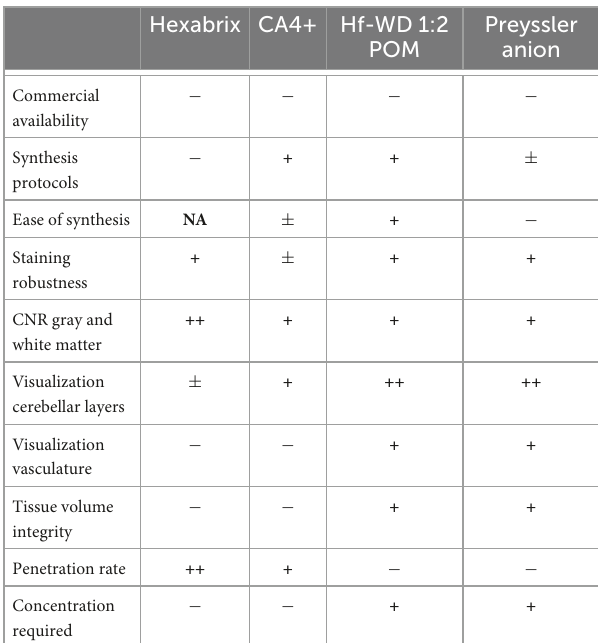
TABLE 3 Summary of certain key factors to consider when applying the evaluated